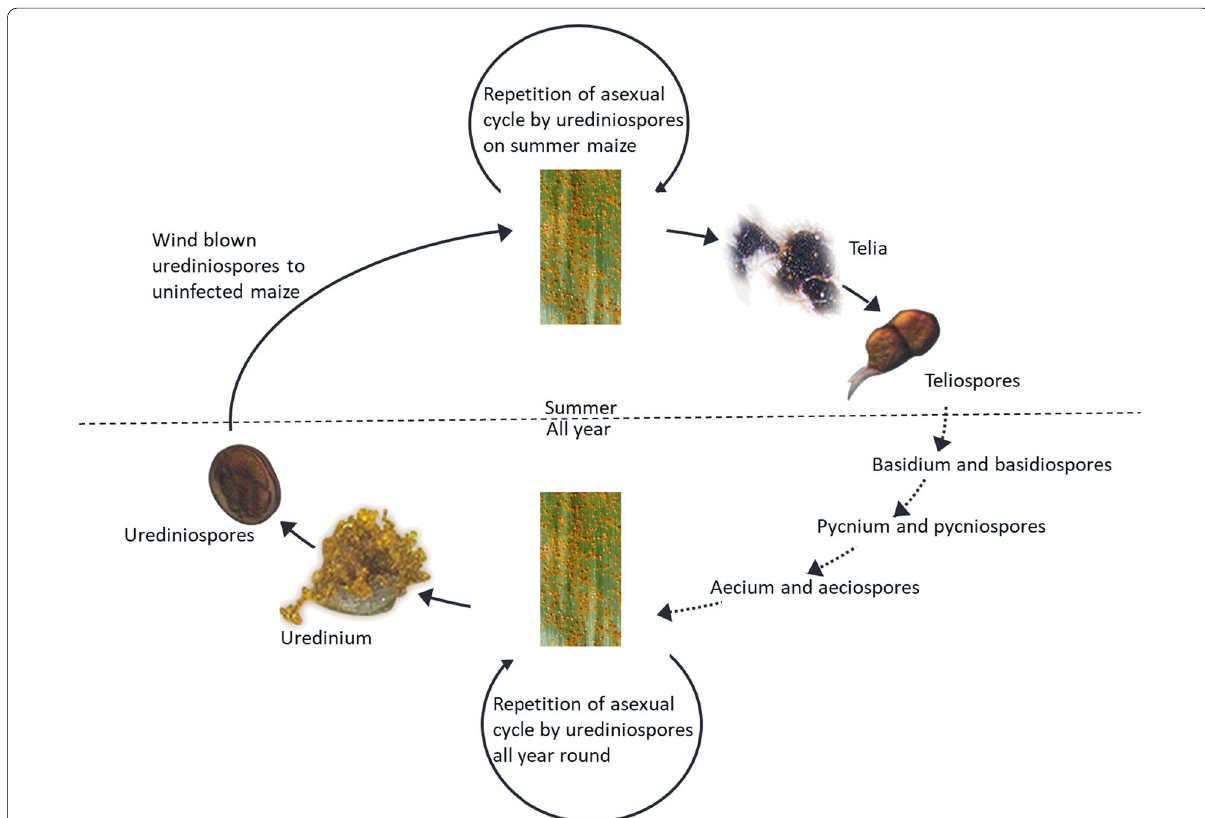
Fig. 5 Disease cycle of southern corn rust in China. Two types of disease symptoms were observed on maize, the uredinial stage with corresponding urediniospores and the telial stage with teliospores (Crouch and Szabo 2011). The disease symptoms at the basidial, pycnial and aecial stages appearing on an alternate host are unknown. The pathogen can survive and repeat its asexual cycle by urediniospores throughout the year in south. In summer, the wind transports urediniospores from south to north where the pathogen cannot